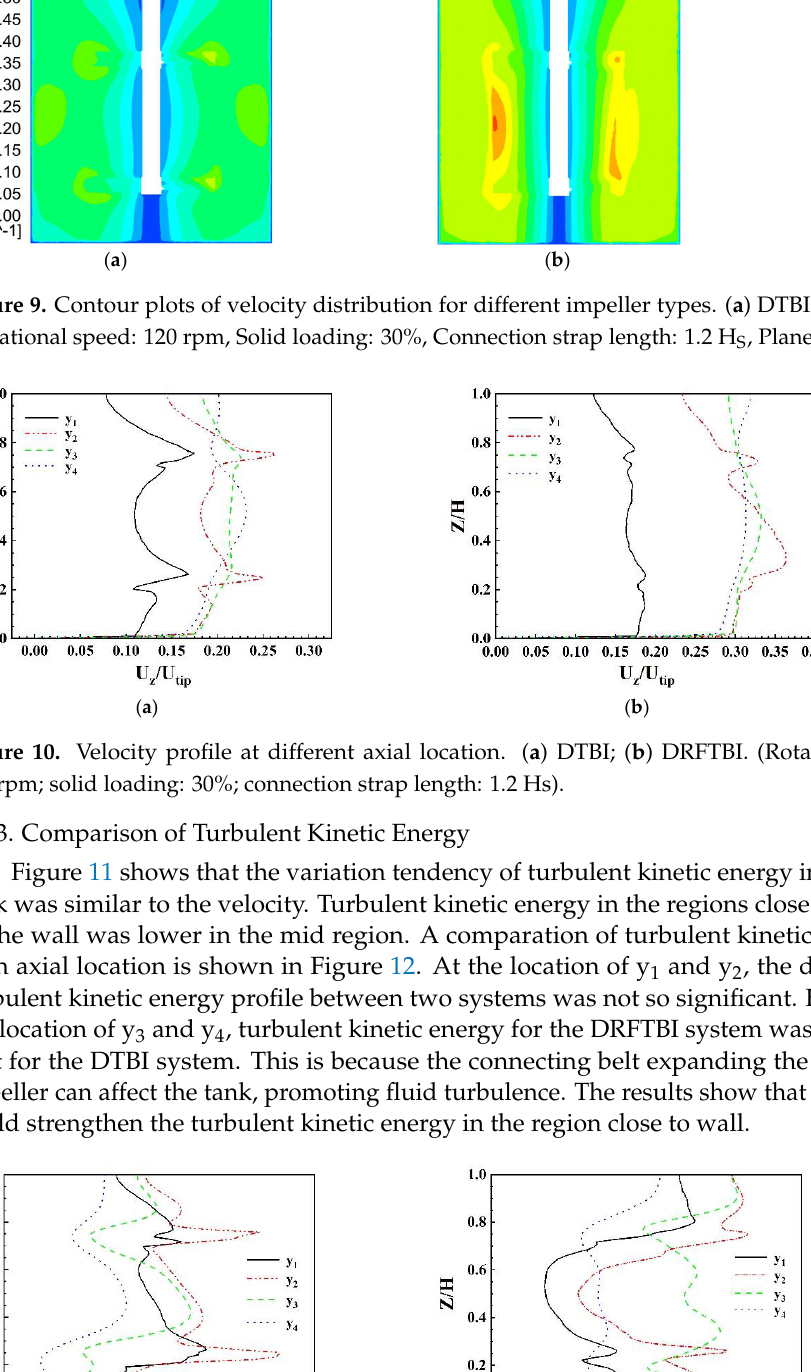
Figure 11. Turbulent kinetic energy profile at different axial location. ( a ) DTBI; ( b ) DRFTBI. (Rota- tional speed: 120 rpm; solid loading: 30%; connection strap length: 1.2 Hs.)